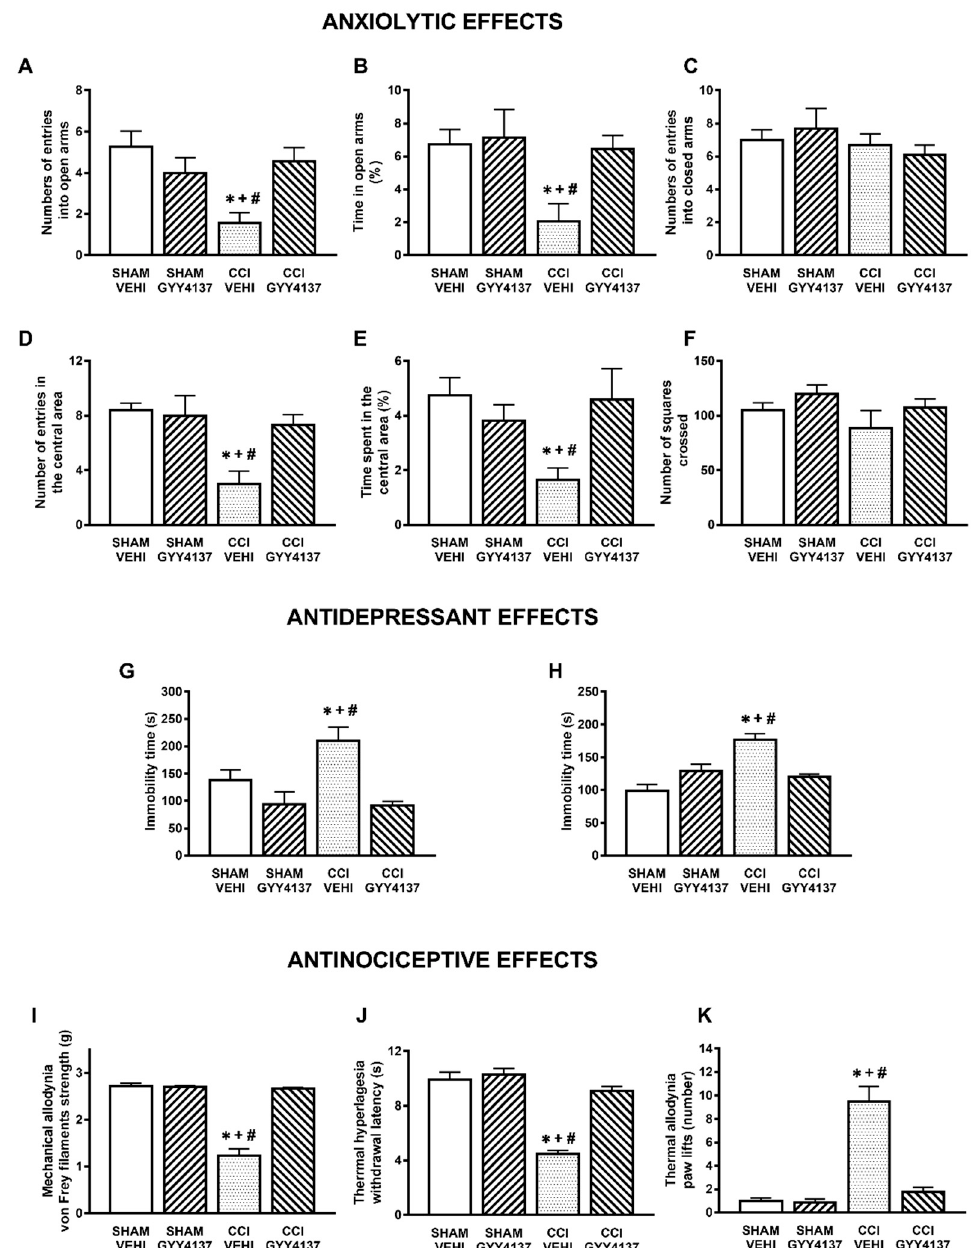
Figure 2. Treatment with GYY4137 inhibited the anxiety- and depressive-like behaviors and the nociceptive responses induced by nerve injury. Effects of the repeated administration with GYY4137 or vehicle at 32 µ mol/kg for 4 days, at 2 times for each day, on the anxiety-, depressive-, and nociceptive-like behaviors induced by nerve injury at 30 days after surgery. The effects of GYY4137 or vehicle in sham-operated mice are also displayed. In the EPM test, the number of entries to the open arms ( A ), percentage of the time spent in the open arms ( B ), and the number of entries into the closed arms ( C ) are shown. In the OF test, the number of entries in the central area ( D ), the percentage of time spent in the central area ( E ), and the number of squares crossed ( F ) are presented. In the TST ( G ) and FST ( H ), the immobility times (s) are shown. The effects of GYY4137 in the mechanical allodynia ( I ), thermal hyperalgesia ( J ), and thermal allodynia ( K ) in the ipsilateral paw of sham-operated or sciatic nerve-injured mice are also indicated. For each test: * denotes significant differences vs. sham-operated mice treated with vehicle, + vs. sham-operated mice treated with GYY4137, and # vs. CCI mice treated with GYY4137 ( p < 0.05; one-way ANOVA followed by the Student–Newman–Keuls test). Mean values ± SEM; n = 6–8 animals. Regarding the antidepressant effects, both treatments reduced the high immobility time observed in sciatic nerve-injured animals treated with vehicle in the TST ( p <